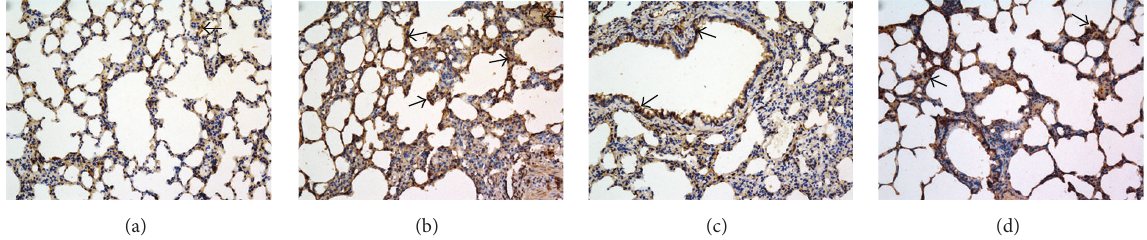
Figure 5: TGF- 𝛽 1 immunohistochemical dyeing in lung tissues. TGF- 𝛽 1 immunohistochemical dyeing in control group (a), PAO1 group (b), Δ lasI Δ rhlI group (c), and Δ lasR Δ rhlR group (d). Arrows indicate TGF- 𝛽 1 protein, which was stained yellow and mainly localized in the cytoplasm and cell membrane of positive cells. DAB stain, original magnification, × 200.